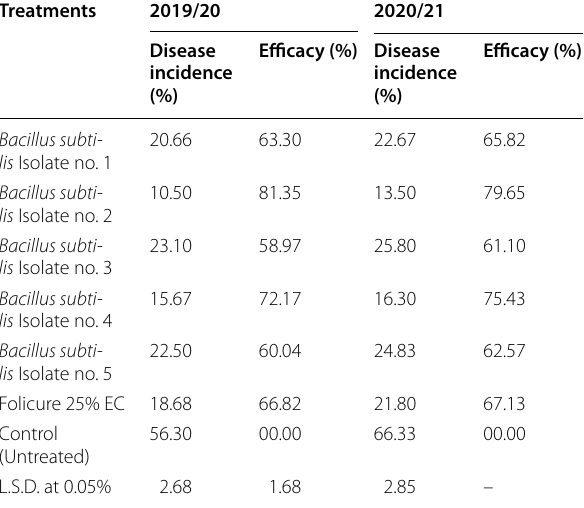
Table 3 Effect of Bacillus subtilis and Folicure treatments on onion white rot incidence under field conditions at Mallawi,